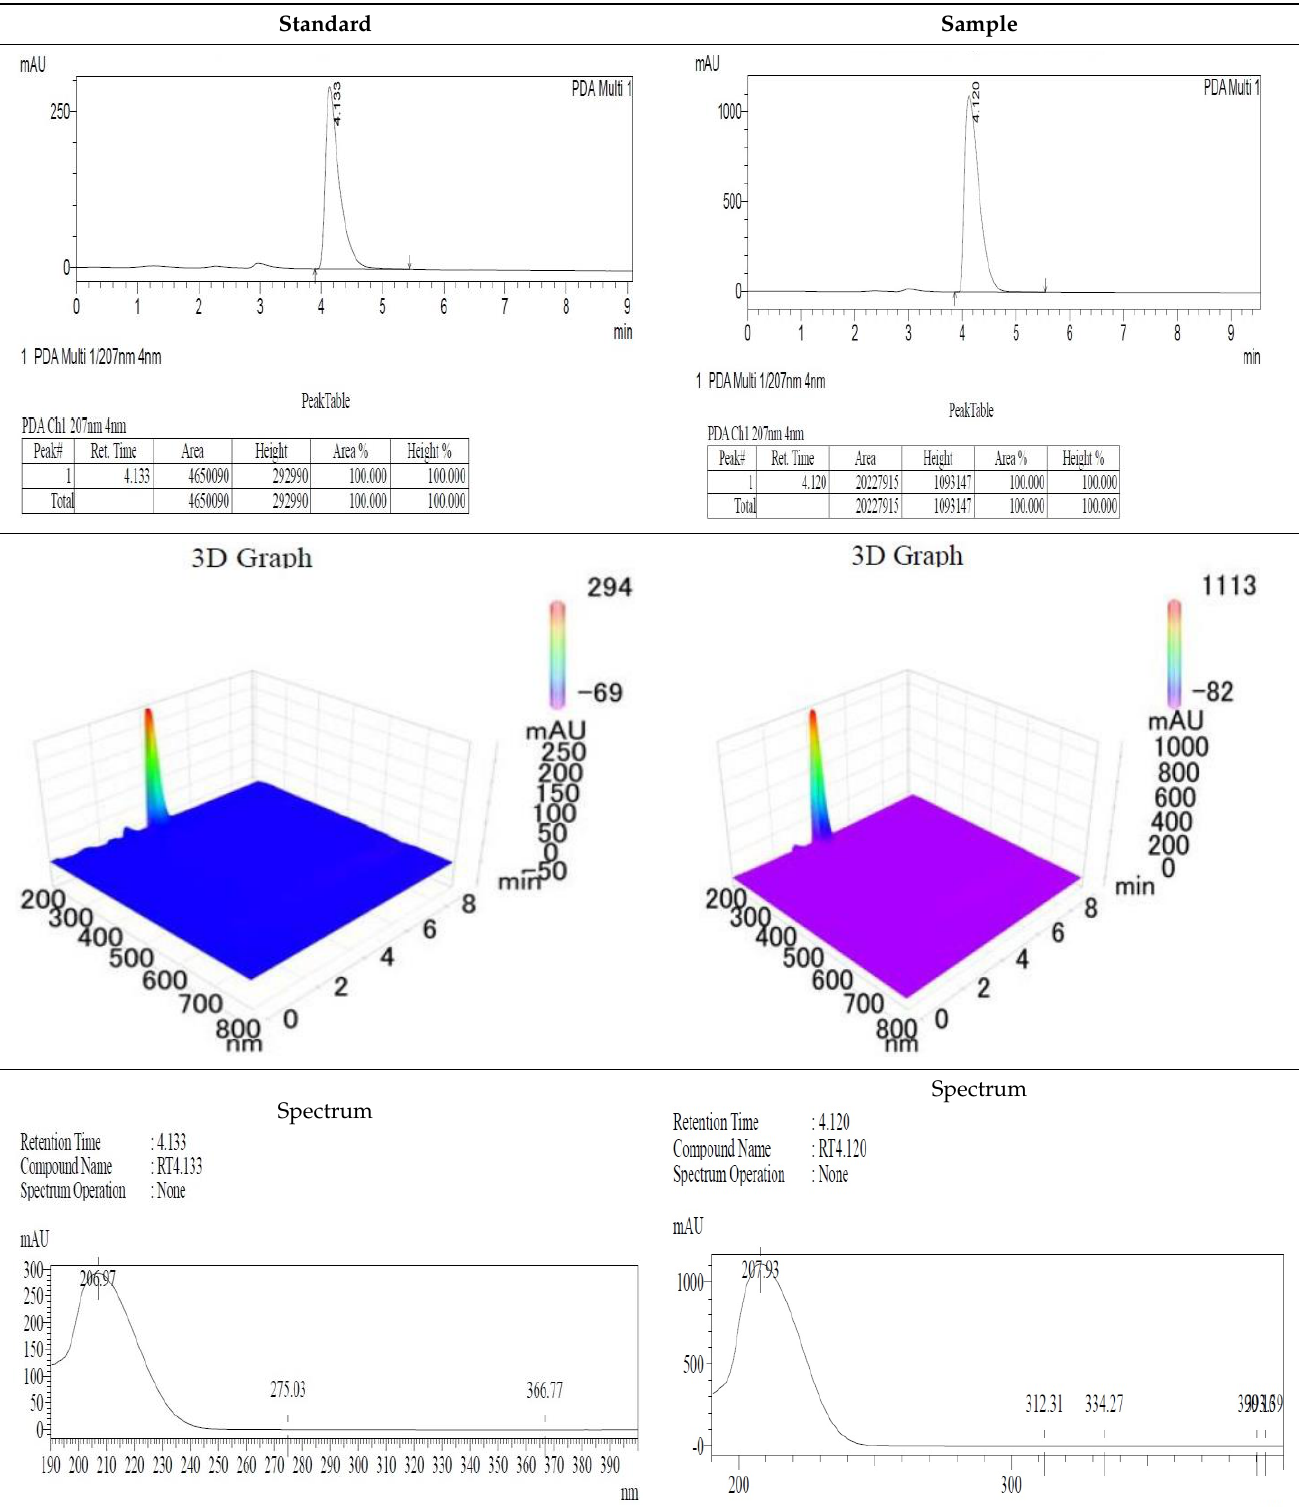
Table 1. Chromatogram, 3D graph and UV spectrum of the friedelin sample and the standard.